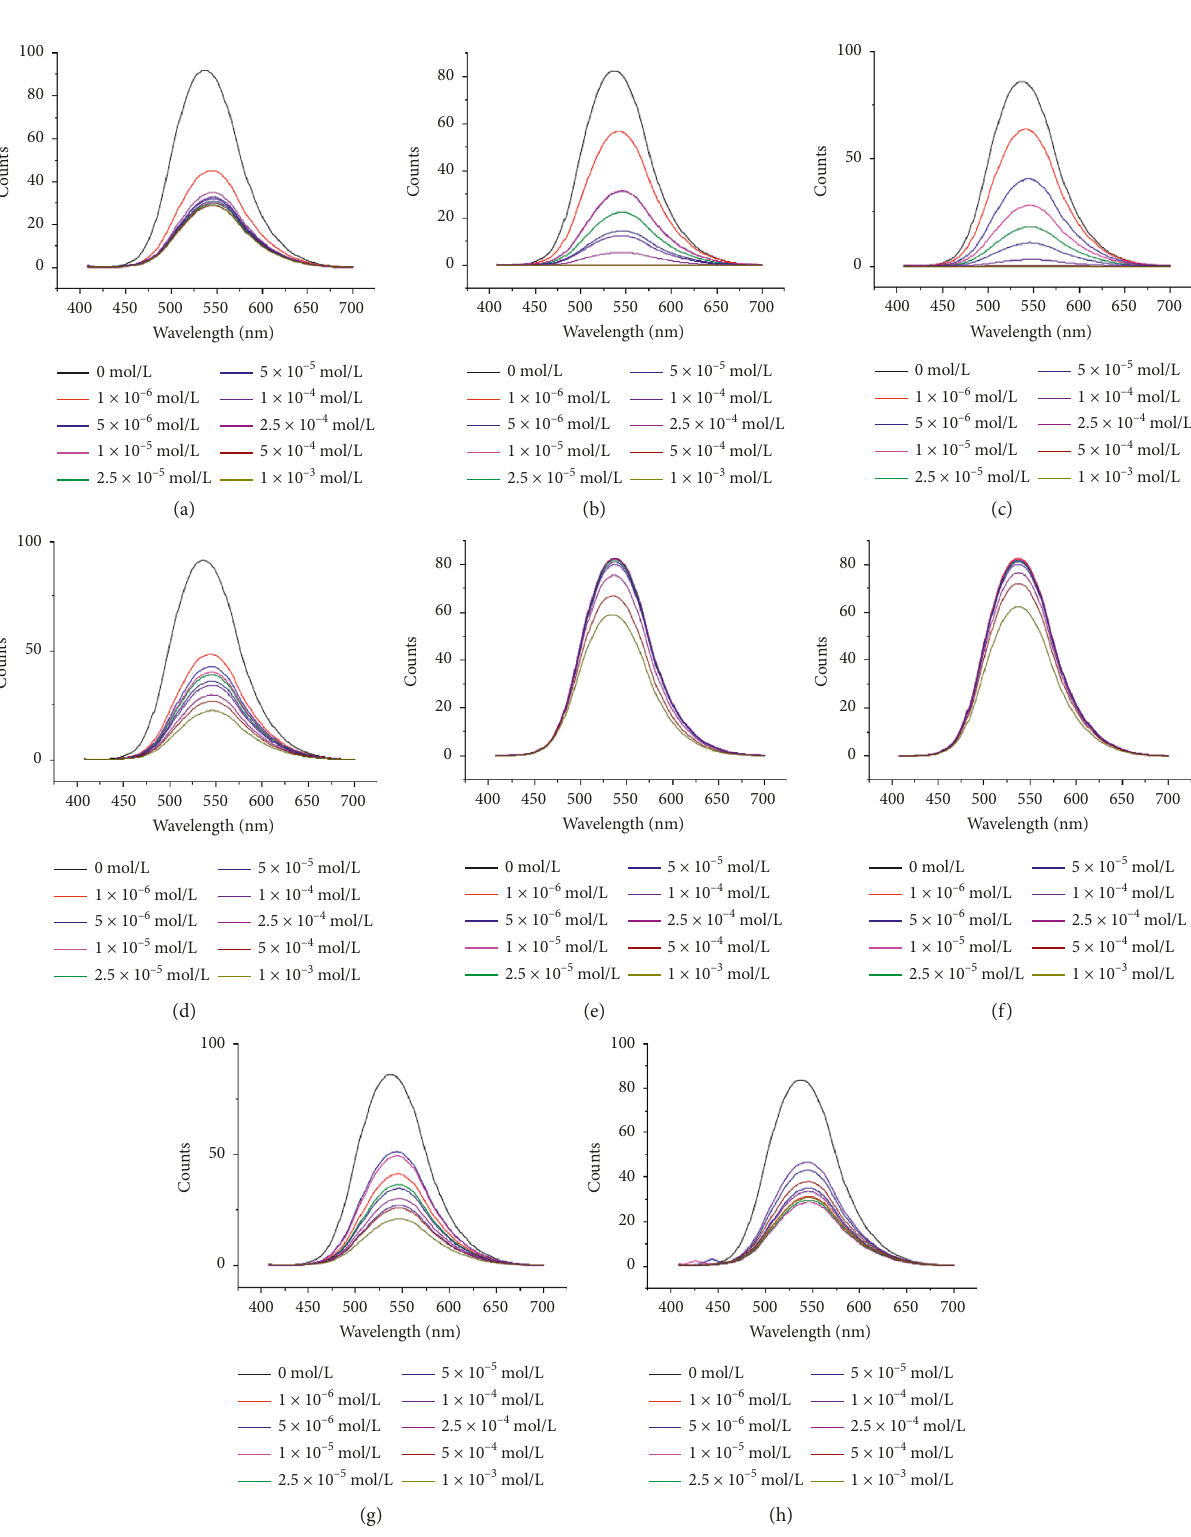
Figure 3: Fluorescence emission spectra of heterocyclic Schiff base derivatives 1 – 8 (a–h) (2.7 × 10 − 4 M) in the presence of increasing [DNA] (5.6–6.2 × 10 − 5